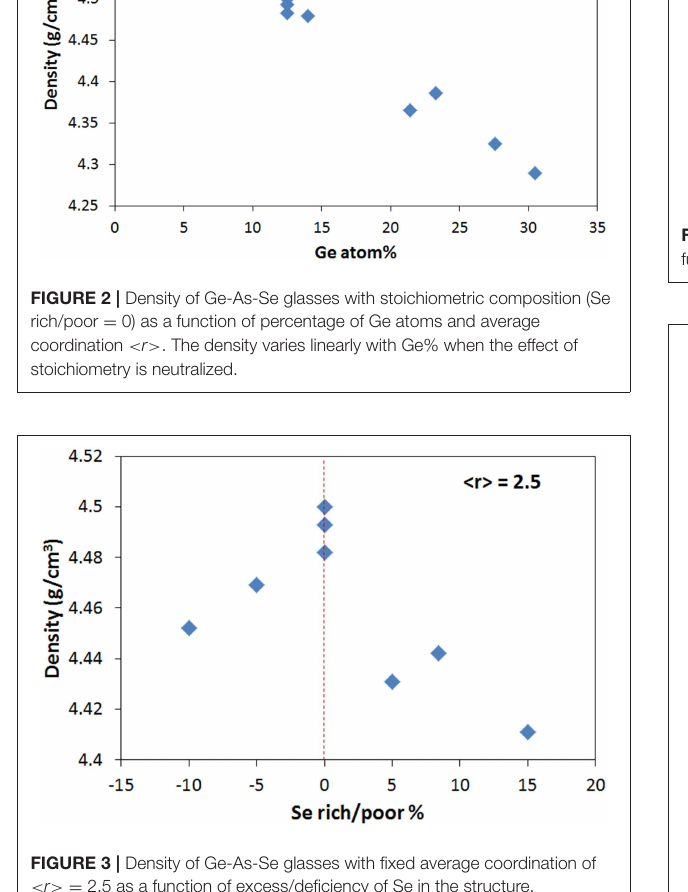
evolution of the structural dimensionality in this glass